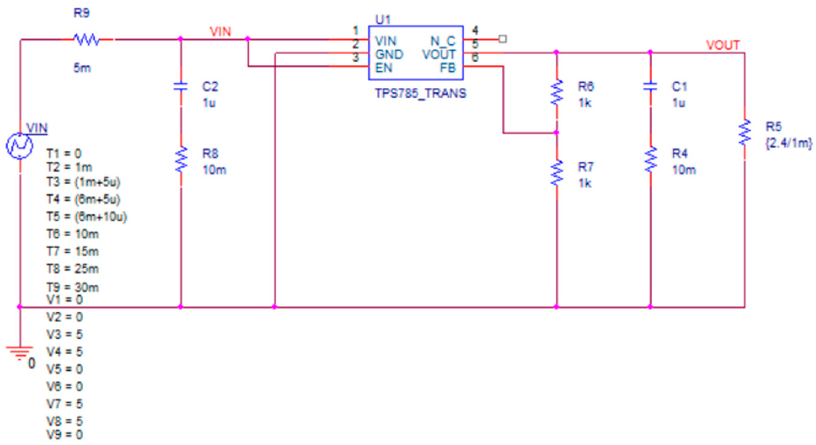
Figure 5. Demonstration application circuit of TPS785-Q1 provided by Texas Instruments [19].